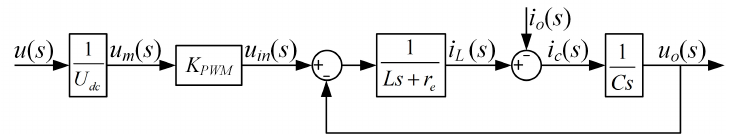
Figure 2. Equivalent model of the single-phase inverter.